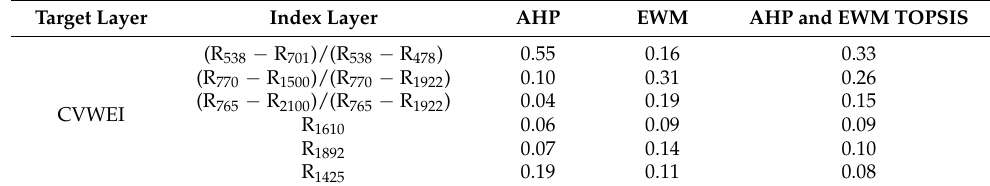
Table 4. Weights of the individual feature